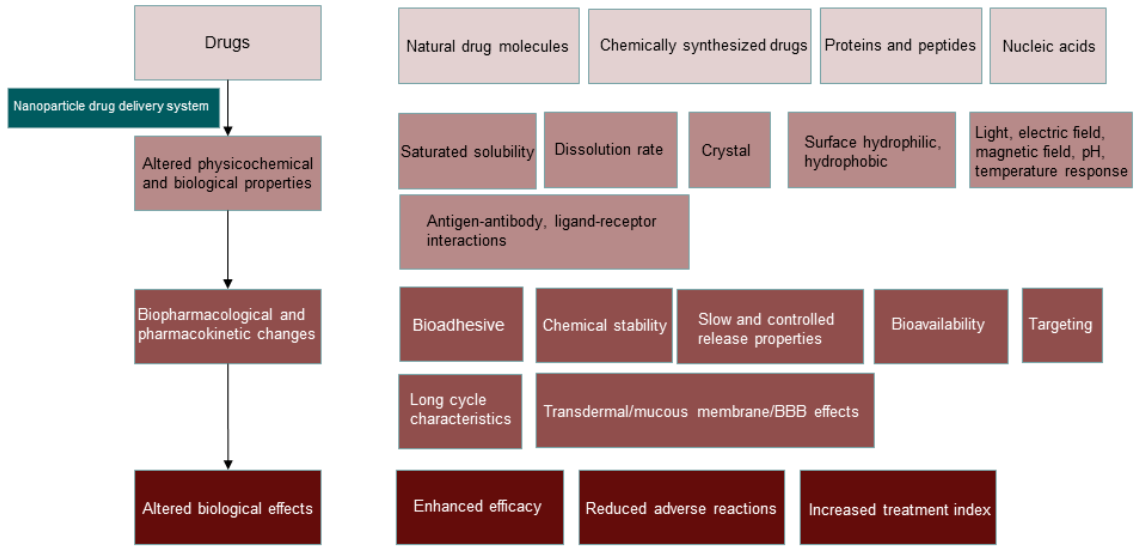
Figure 6. The basis of biological effects of nanomedicines. After nanosized drugs, their physical properties and biological characteristics are changed, thus affecting the distribution, metabolism and excretion of drugs, and finally achieving the purpose of enhancing drug efficacy, reducing adverse drug reactions and improving drug effects.